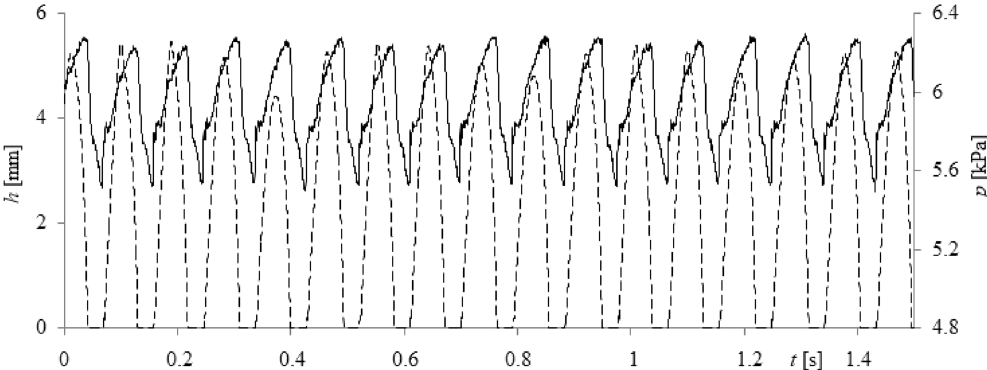
Figure 9. Time series of liquid penetration into the capillary and air pressure fluctuations for water, given for an air volume flow rate of q = 0.026 l/min. Solid lines represent pressure fluctuations in the gas, and dashed lines are used to represent the time series of liquid penetration inside the